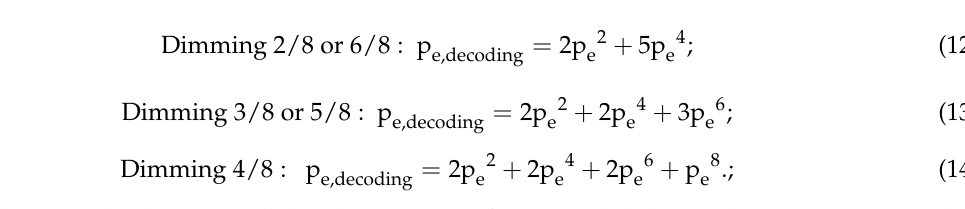
Figure 12. The comparison of symbol error rate (SER) performance between an NN-based decoder and a matched filter on different dimming cases with a blur kernel size of 40 × 40.